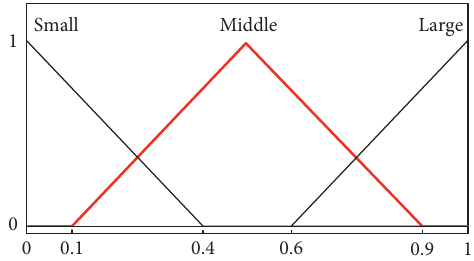
Figure 25: FV membership functions for LV Size